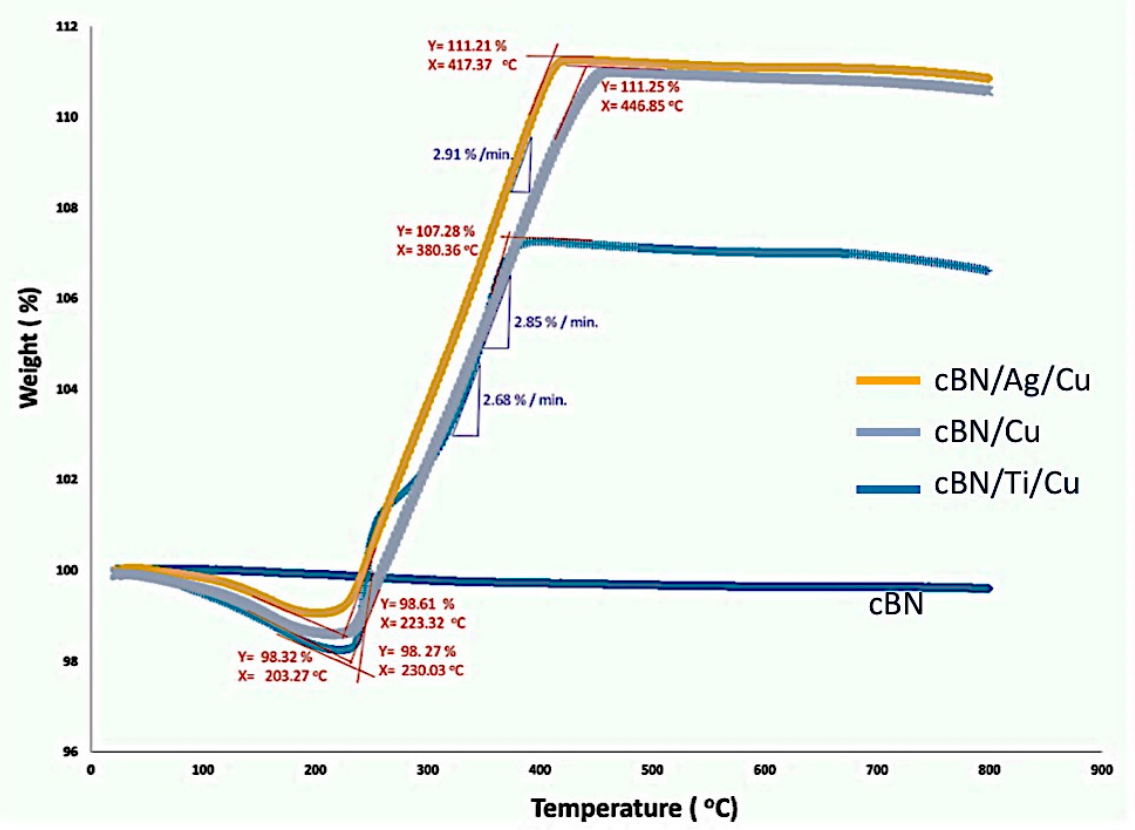
Figure 13. TGA curves of the uncoated cBN abrasive particles as well as the produced 10 wt.% cBN/Cu composite powders by different metallization techniques followed by the electroless deposition process.